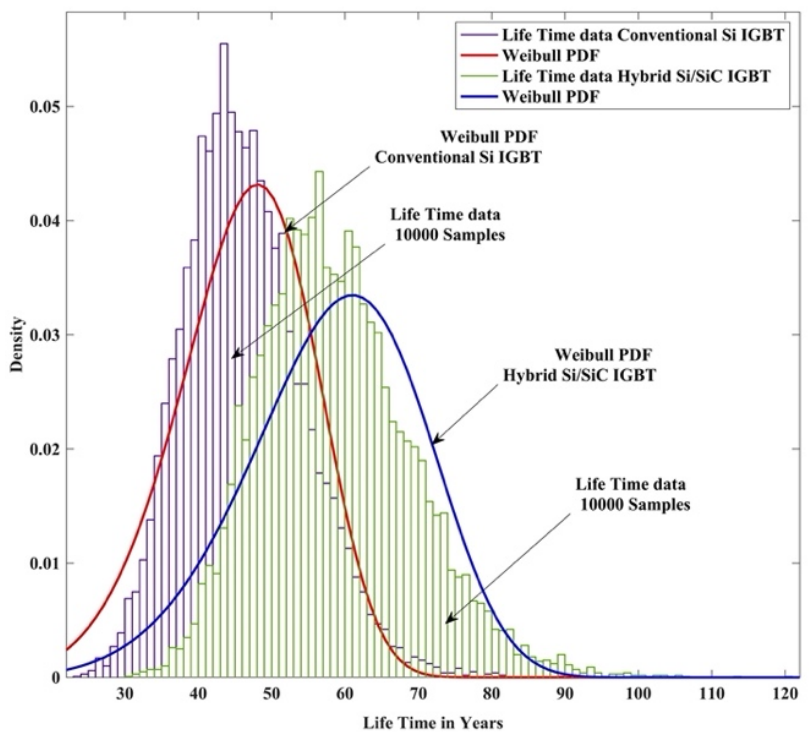
Figure 9. Lifetime distribution.